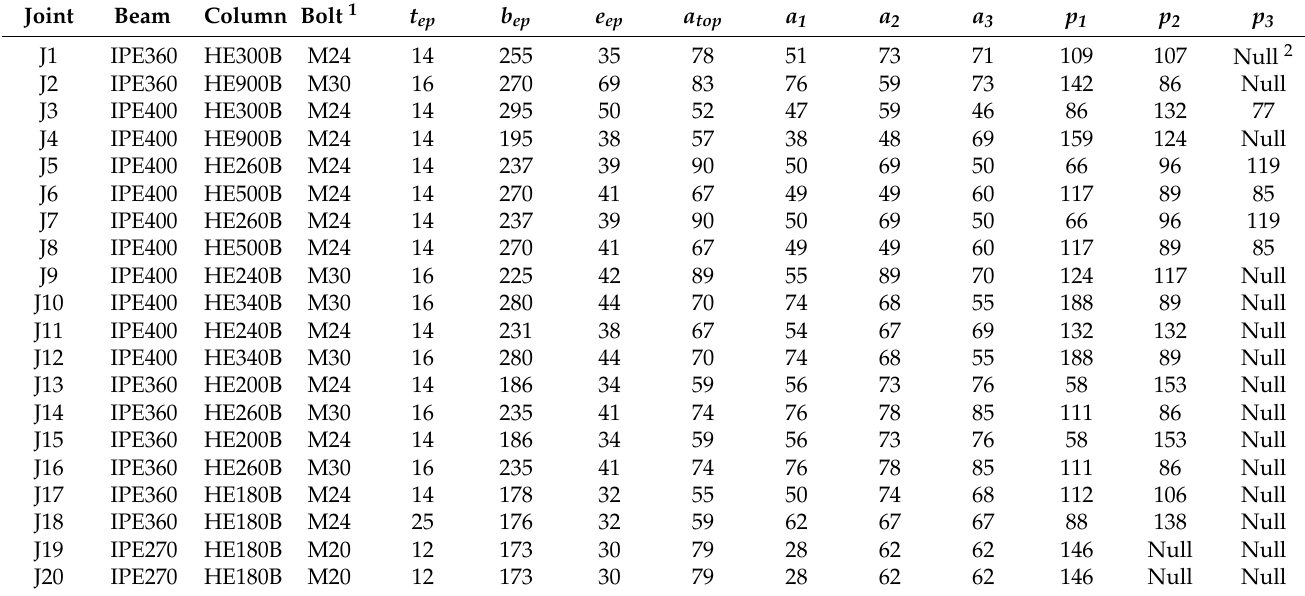
Table 8. Final connection details (size in